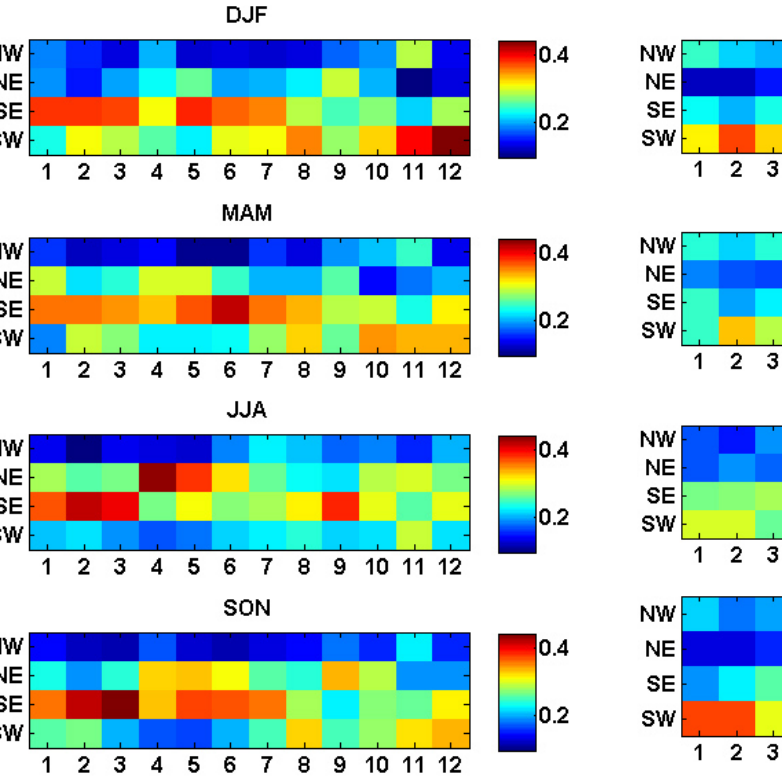
Figure 11. Relative contribution of wind direction to the total num- ber of precipitation